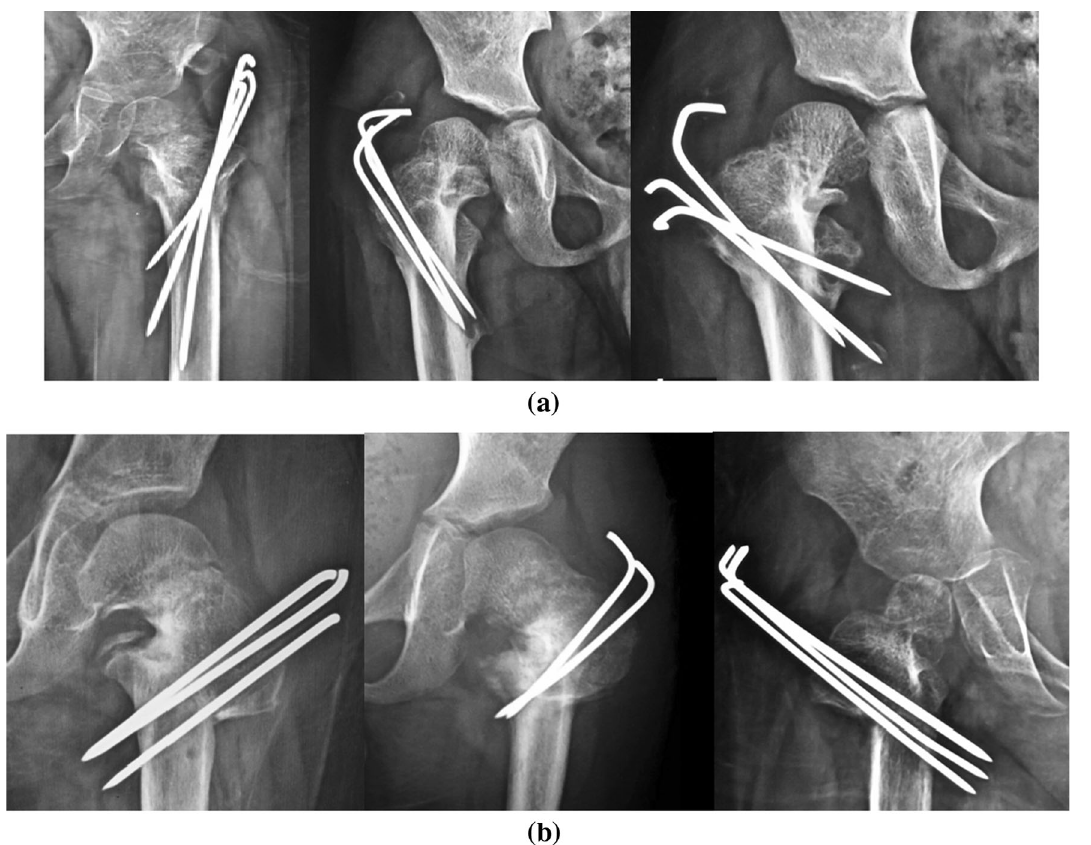
Fig. 9 Alignment of the femur after corrective osteotomy and fixation. a Proper alignment with no medialization of the distal fragment. b Medialization of the distal